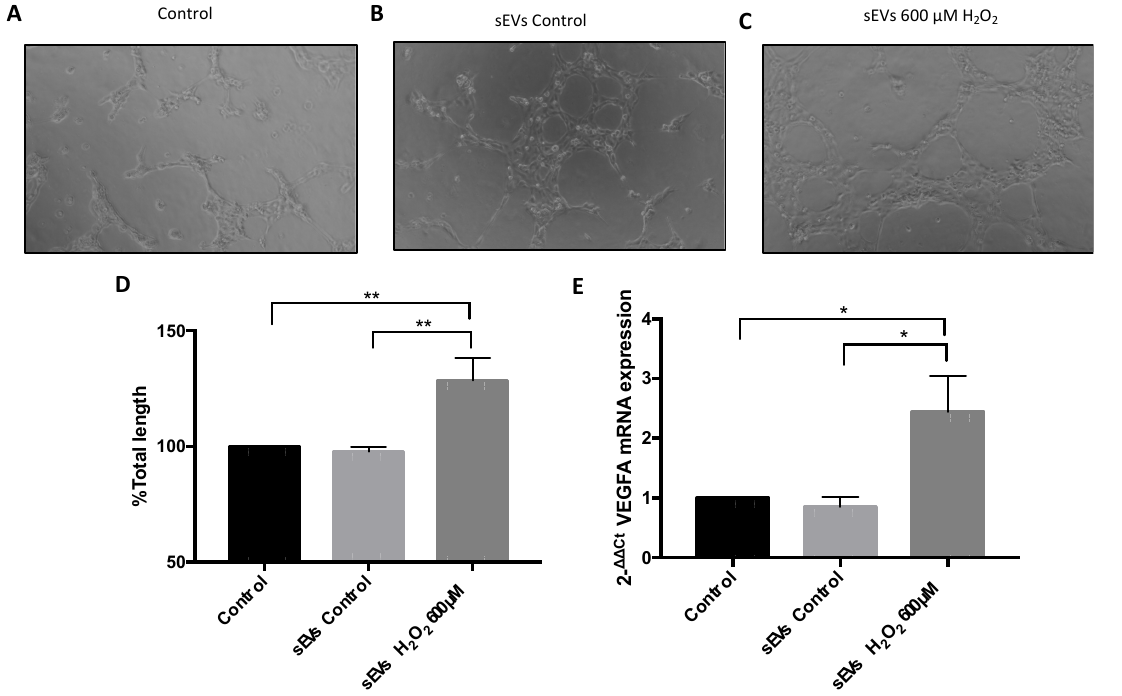
Figure 5. sEV-mediated vasculogenesis. HUVEC tube formation subject to different ARPE-19 cell culture media. Control medium (100 ± 0) ( A ), control sEVs (117.2 ± 1.79) ( B ), and sEV H 2 O 2 600 µM (128.7 ± 9.52) ( C ). Scale bar: 100 µM. Total length ( D ) was calculated. mRNA VEGFA expression after 24 h of sEVs control (0.85 ± 0.16) and sEVs H 2 O 2 600 µM (2.44 ± 0.6) exposure in ARPE-19 cells ( E ). Values are expressed as mean ± SEM ( n = 3; Matrigel assay and n = 5; mRNA expression analysis). The p -value was obtained by ANOVA; * p < 0.05 and ** p < 0.01.